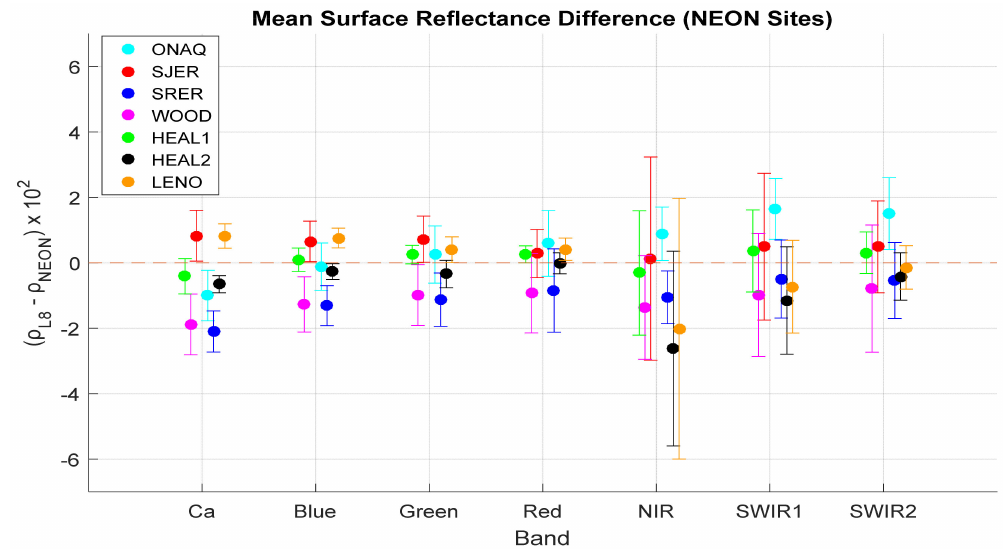
Figure 18. Mean reflectance di ff erence between OLI and NIS SR